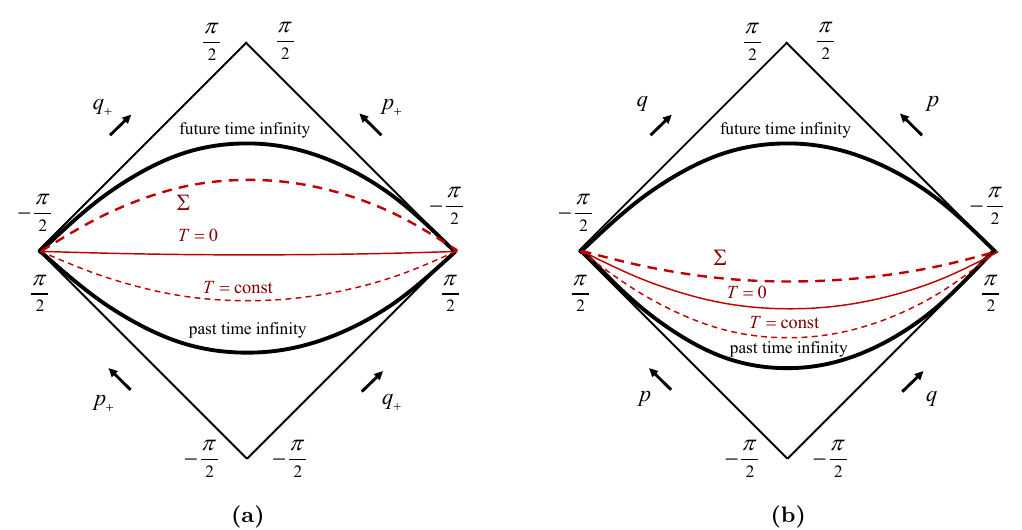
Figure 5. (a) Conformal diagram in ( p + , q + ) coordinates. (b) Conformal diagram in ( p, q ) coor-